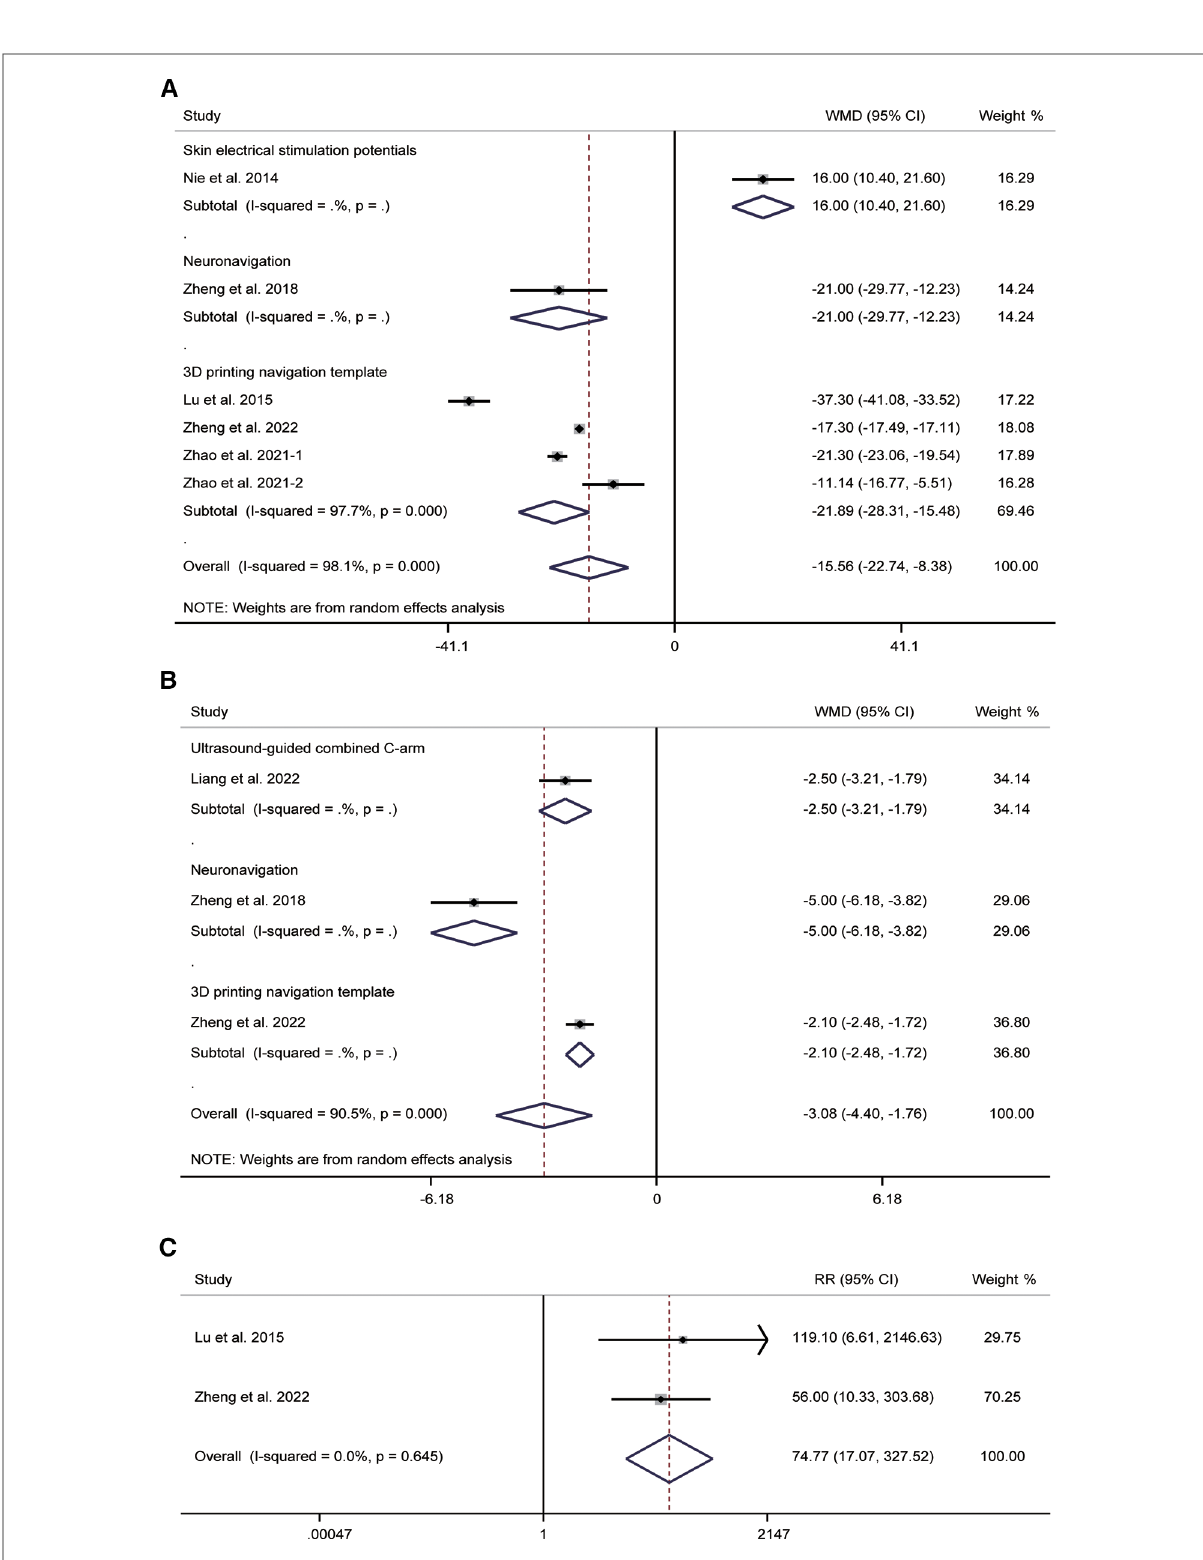
FIGURE 8 Forest plot of operation time ( A ), times of intraoperative fl uoroscopy ( B ), and the success of the fi rst puncture ( C ) for the comparison of different guidance techniques (combined with other guidance techniques vs. simple image